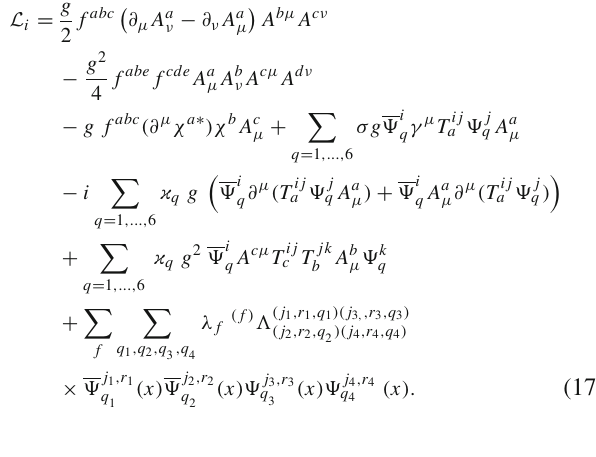
quark condensate effects obtained in references [21,22]. The four quark legs vertices are the ones generated by the NJL four quark interactions. There is a maximal number F of such vertices being invariant under the symmetries of